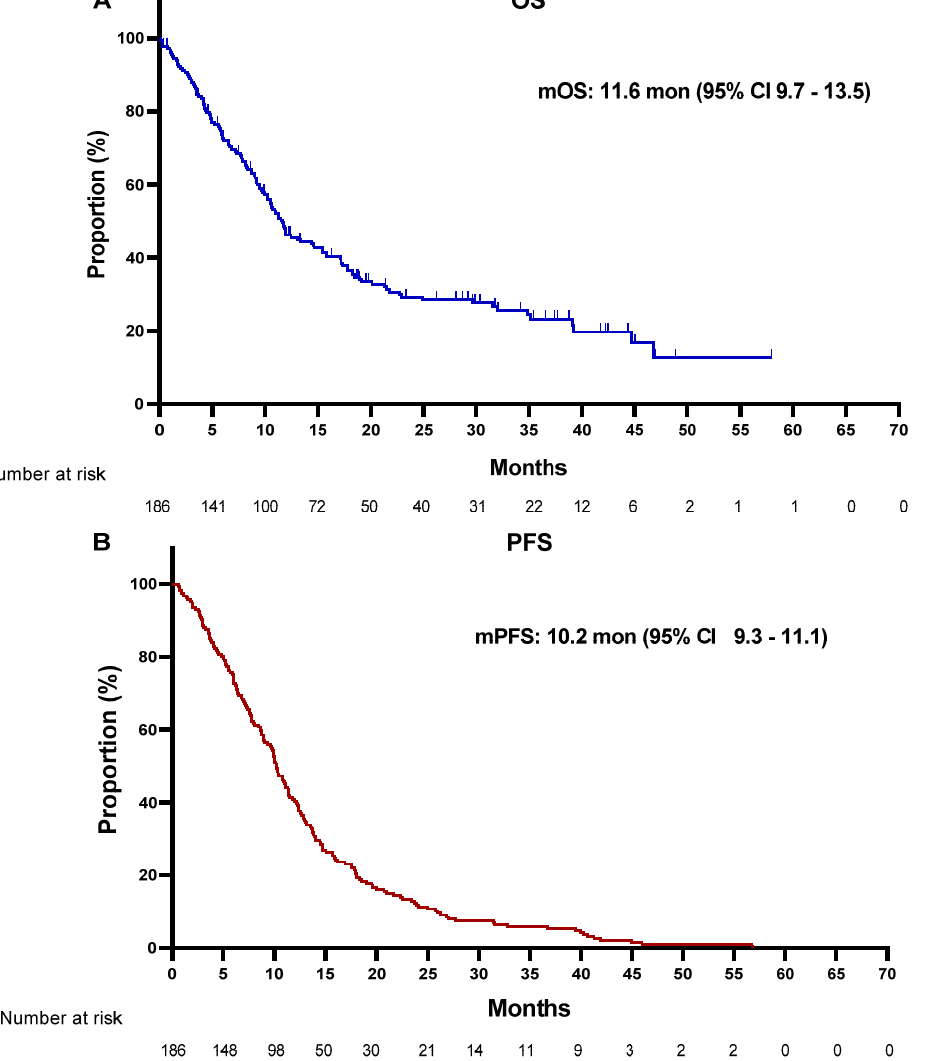
Figure 1. Kaplan–Meier plot for the entire study population. ( A ) Overall survival calculated from the date of MET ISH to the last follow-up date. ( B ) Progression-free survival of most recent tyrosine kinase inhibitor used. mOS, median overall survival; mPFS, median progression-free survival; CI, confidence interval; mon, month.